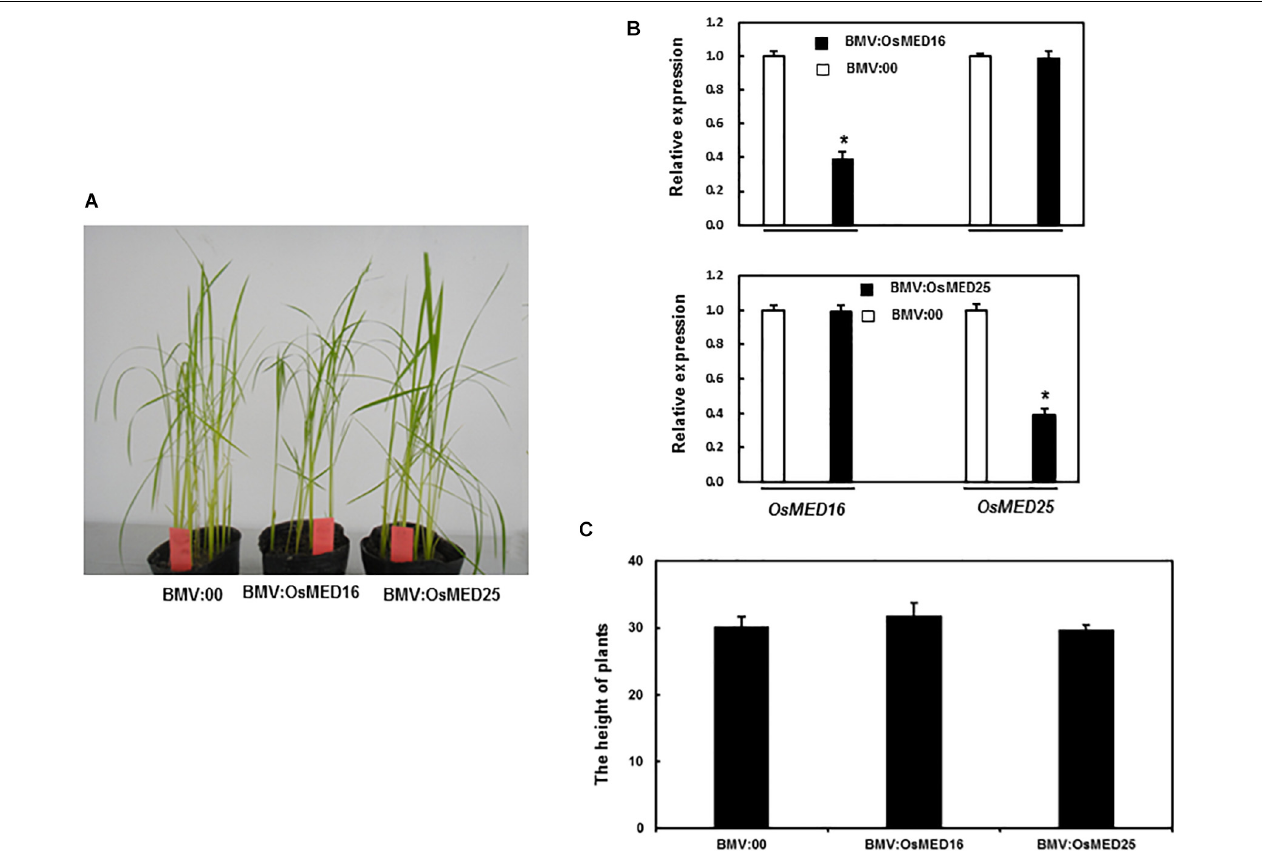
FIGURE 5 | The growth condition of BMV:OsMED16- and BMV:OsMED25- infiltrated plants. (A) Growth conditions of BMV: OsMED16-, BMV: OsMED25-, and BMV:00-infiltrated plants. (B) The silencing specificity of OsMED16 and OsMED25 in BMV:OsMED16- or BMV:OsMED25-infiltrated plants. 10-day-old IR64 plants were infiltrated with agrobacteria carrying BMV: OsMED16-, BMV:OsMED25 or BMV:00 constructs and leaf samples were collected at 4 weeks after agroinfiltration. Transcript levels for OsMED16 and OsMED25 were analyzed by qRT-PCR using a rice OsActin gene as an internal control. (C) Heights of BMV: OsMED16-, BMV: OsMED25-, and BMV:00-infiltrated plants. *Above the columns indicate significant differences at p < 0.05 between the silencing plants and the